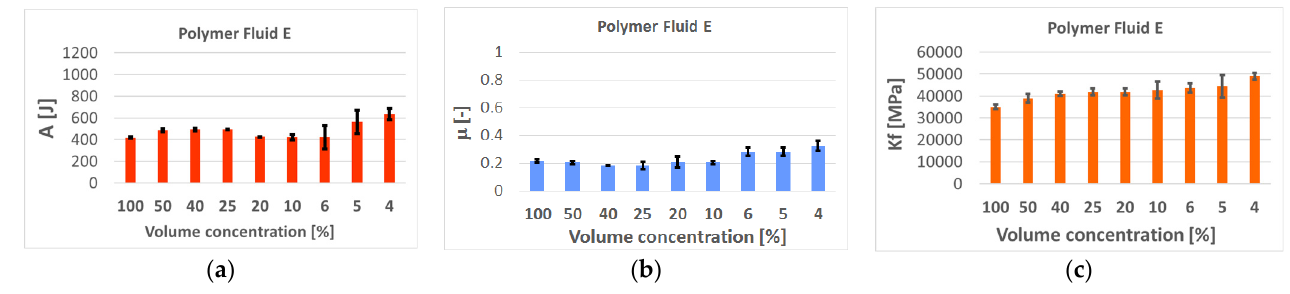
Figure 11. Deformation works ( a ), coefficient of friction ( b ), and specific forming force ( c ) for the polymer E and various concentrations.